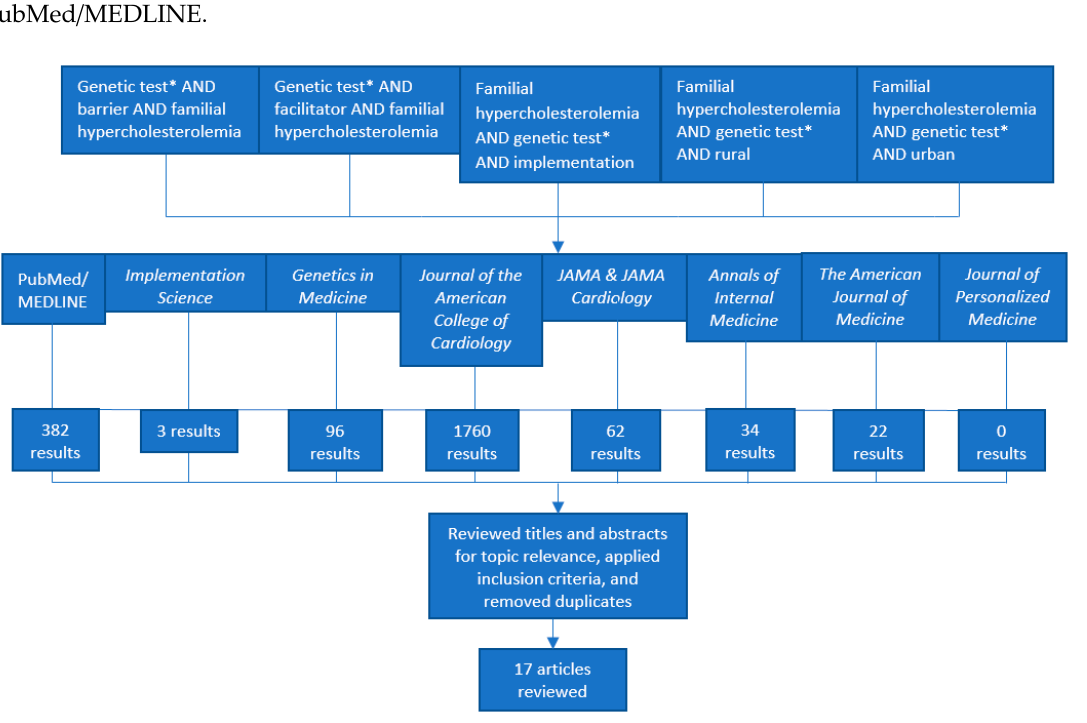
Figure 1. Literature Search Strategy and Results.